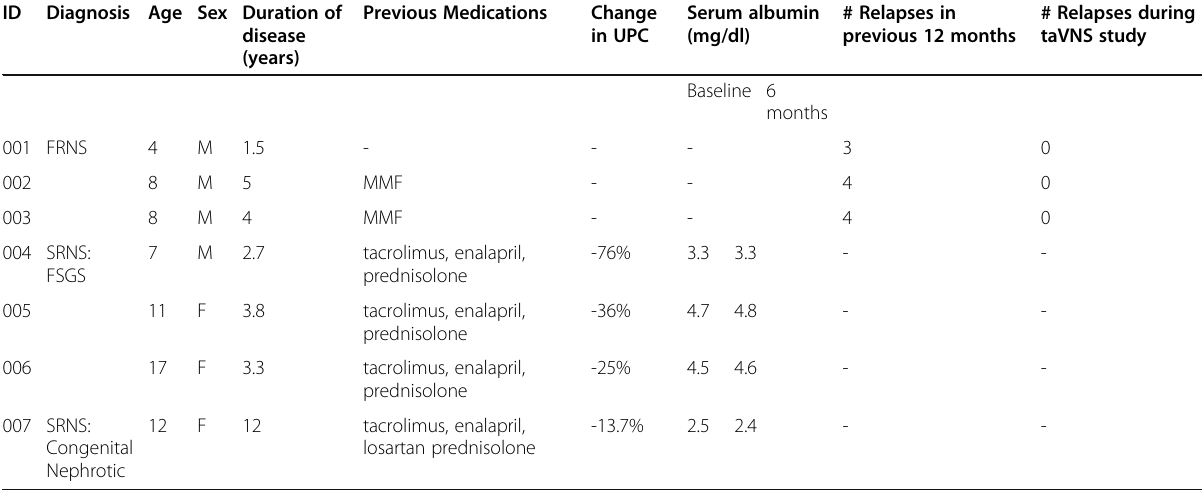
Table 1 Demographic and Clinical Measures of Study Participants ID Diagnosis Age Sex Duration of disease